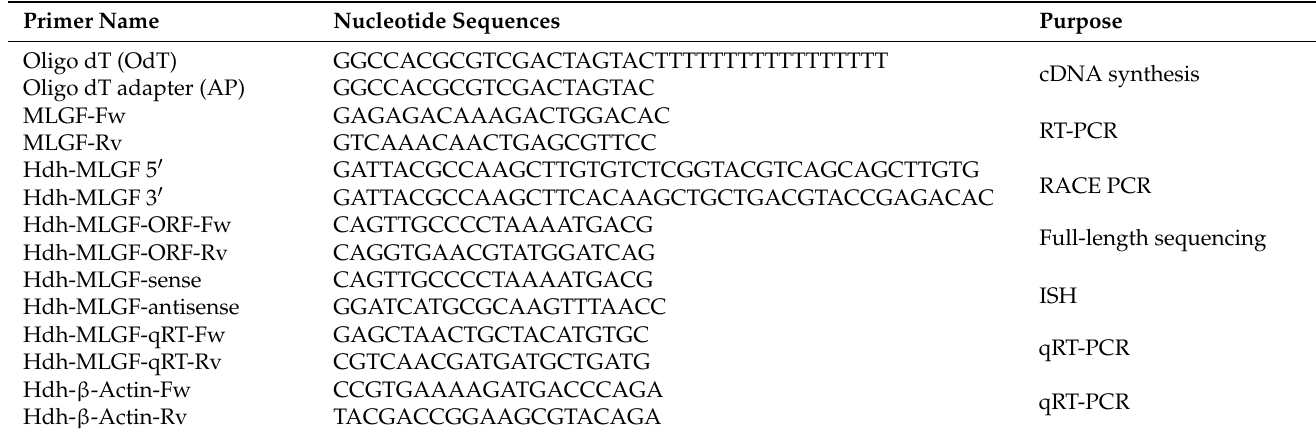
Table 1. Different primers used for cDNA synthesis, cloning, expression analysis, and in situ